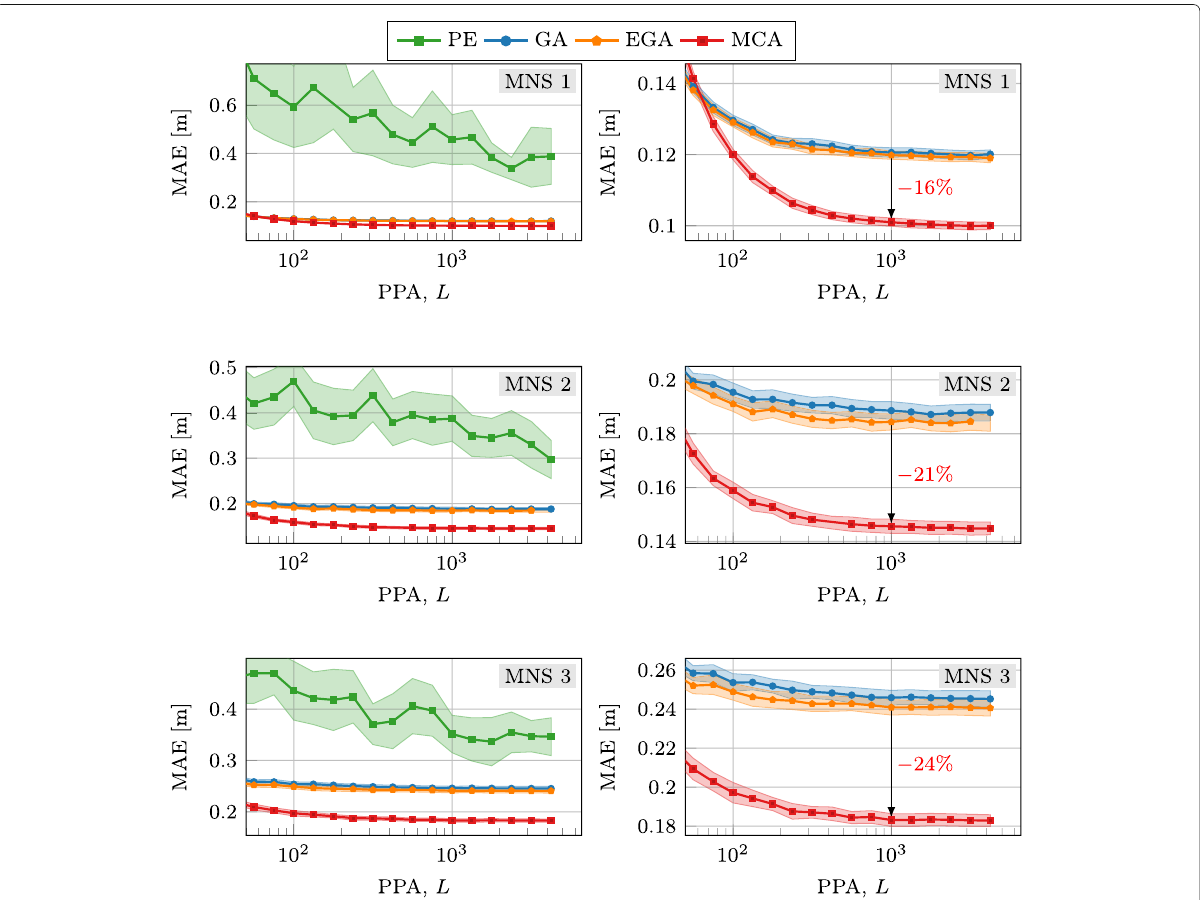
Fig. 4 Localization error as a function of PPA. The plots for MNS 1, MNS 2, and MNS2 3 are at the top, middle, and bottom, respectively. In all panels, M = 4 agents are considered. The right panels show magnified views of the results presented in the upper panels but without the PE results for improved